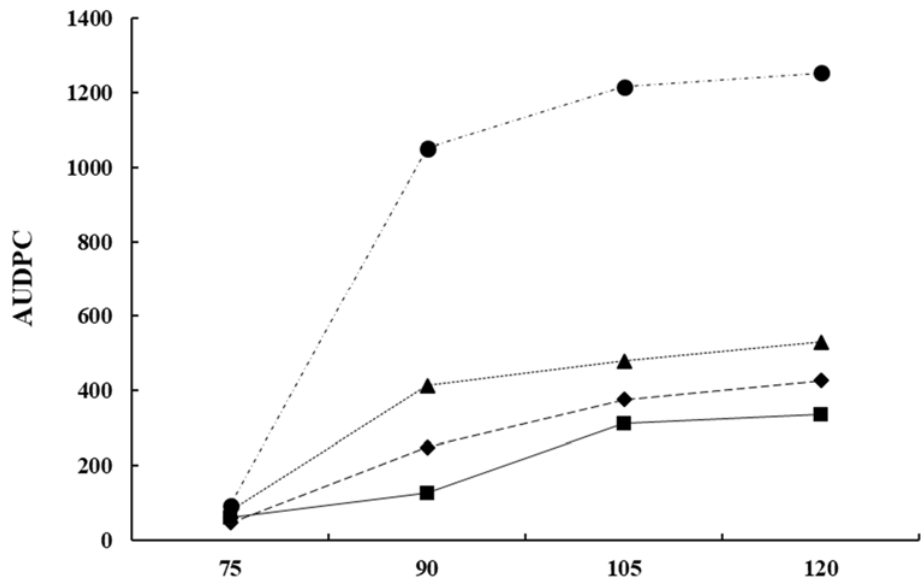
Figure 6. The area under disease progress curve (AUDPC) of anthracnose caused by C. lupini on the Andean lupin susceptible cultivar I.450 Andino. Natural pressure of inoculum represented as the control (Ck ) and the AUDPC by effect of Bacillus subtilis Ctpx ‐ S1 , Ctpx ‐ S2 , and Ctpx ‐ Z3 . AUDPC calculates scores for lupin anthracnose severity on the 1 ‐ to ‐ 6 scale [102]. Pooled data from the 2015 and 2019 growing seasons at El Chaupi, Cantón Mejía, Ecuador, each point at disease onset plus 90, 105, and 120 days. Source: [99].